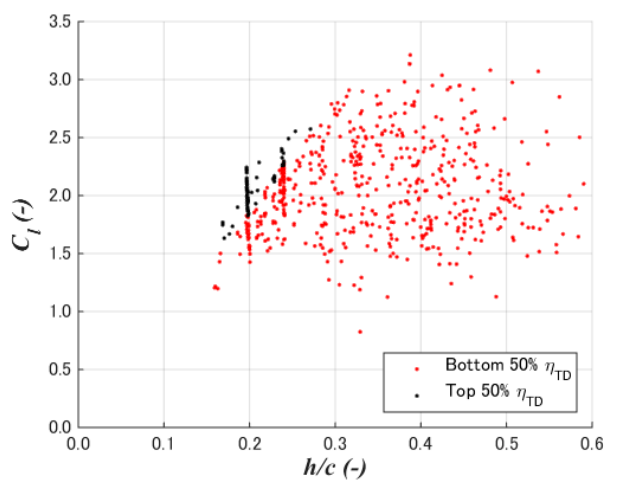
Figure 13. Lift coefficient to diffuser height.